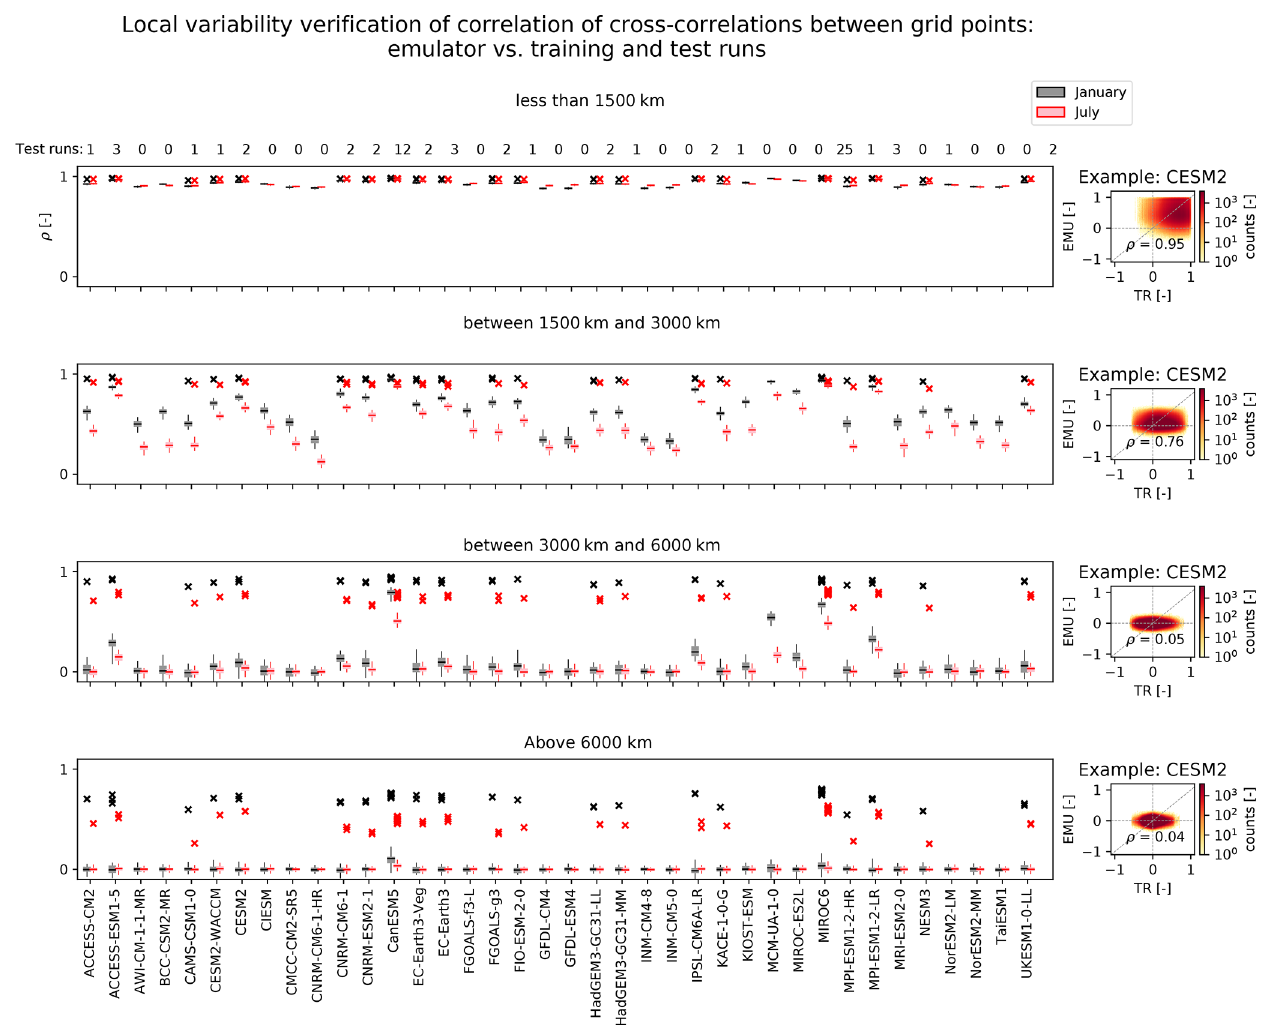
Figure 7. Verification of the spatial representation within the local variability module. Pearson correlations between ESM training run and emulated spatial cross-correlations are considered for four geographical bands centred around the grid point for which temperature is being emulated (rows) at individual months of January (black boxplots) and July (red boxplots). Boxplot whiskers indicate 5th and 95th quantiles. Fifty emulations are evaluated per training run. Where ESM test runs are available, their correlations with training runs are also given for January (black crosses) and July (red crosses). Example 2D histograms of the January spatial cross-correlations for CESM2 training runs versus those of its emulations are given for each geographical